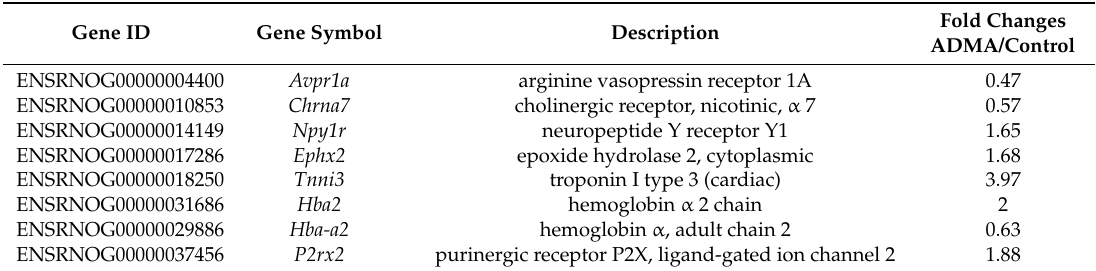
Table 2. Changes in genes related to regulation of BP in the developing kidney treated with ADMA versus control.